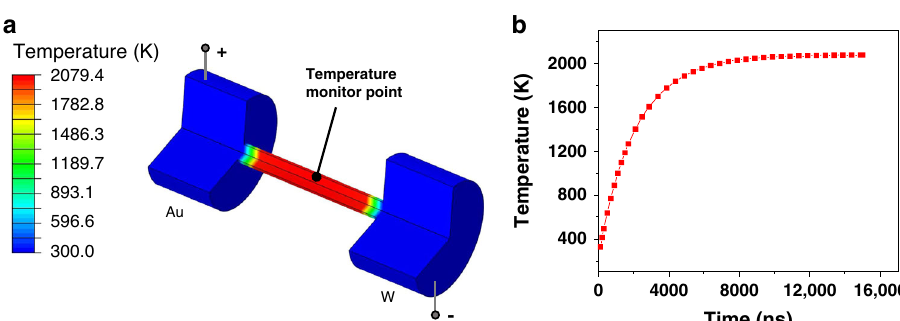
Fig. 4 Finite element analysis of the Joule heating process of a carbon fi ber upon applying the input power of ~40 μ W. a Temperature pro fi le at 10 μ s when the system has reached a thermal equilibrium of ~2000 K. For clarity, a quarter of the model is removed from the result and the electrodes are partially shown. b Temporal evolution of the temperature at the center monitor point (shown in a ) inside the CNF.